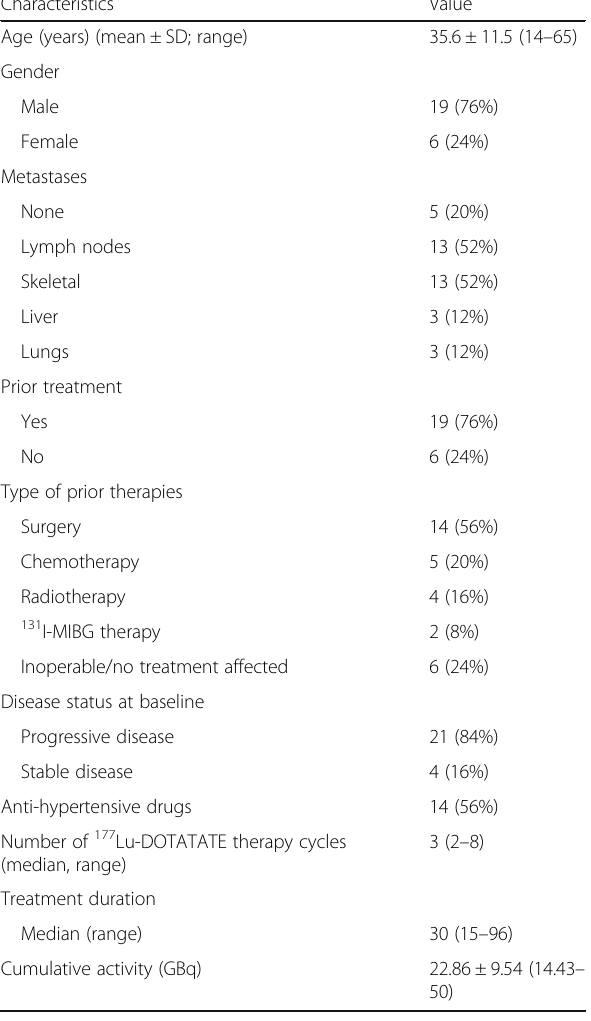
Table 1 Demographic characteristics of patients